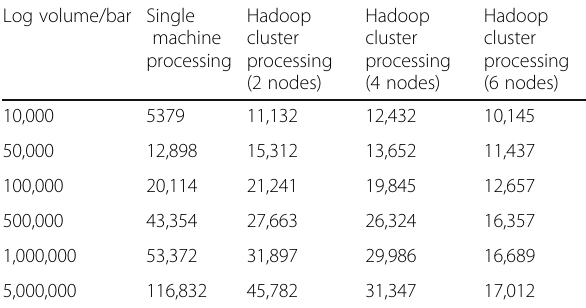
Table 10 Compare the time to log in different modes (unit: